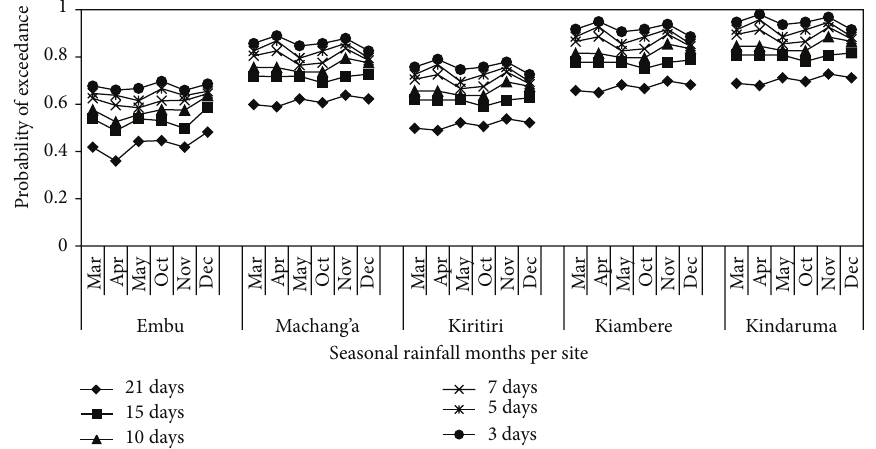
Figure 6: Probability of dry-spells exceeding the 𝑛 (3,5, 7, 10, 15 , and 21) days for each seasonal month calculated using the raw rainfall data from 2000 to 2013 for studied humid and subhumid stations.